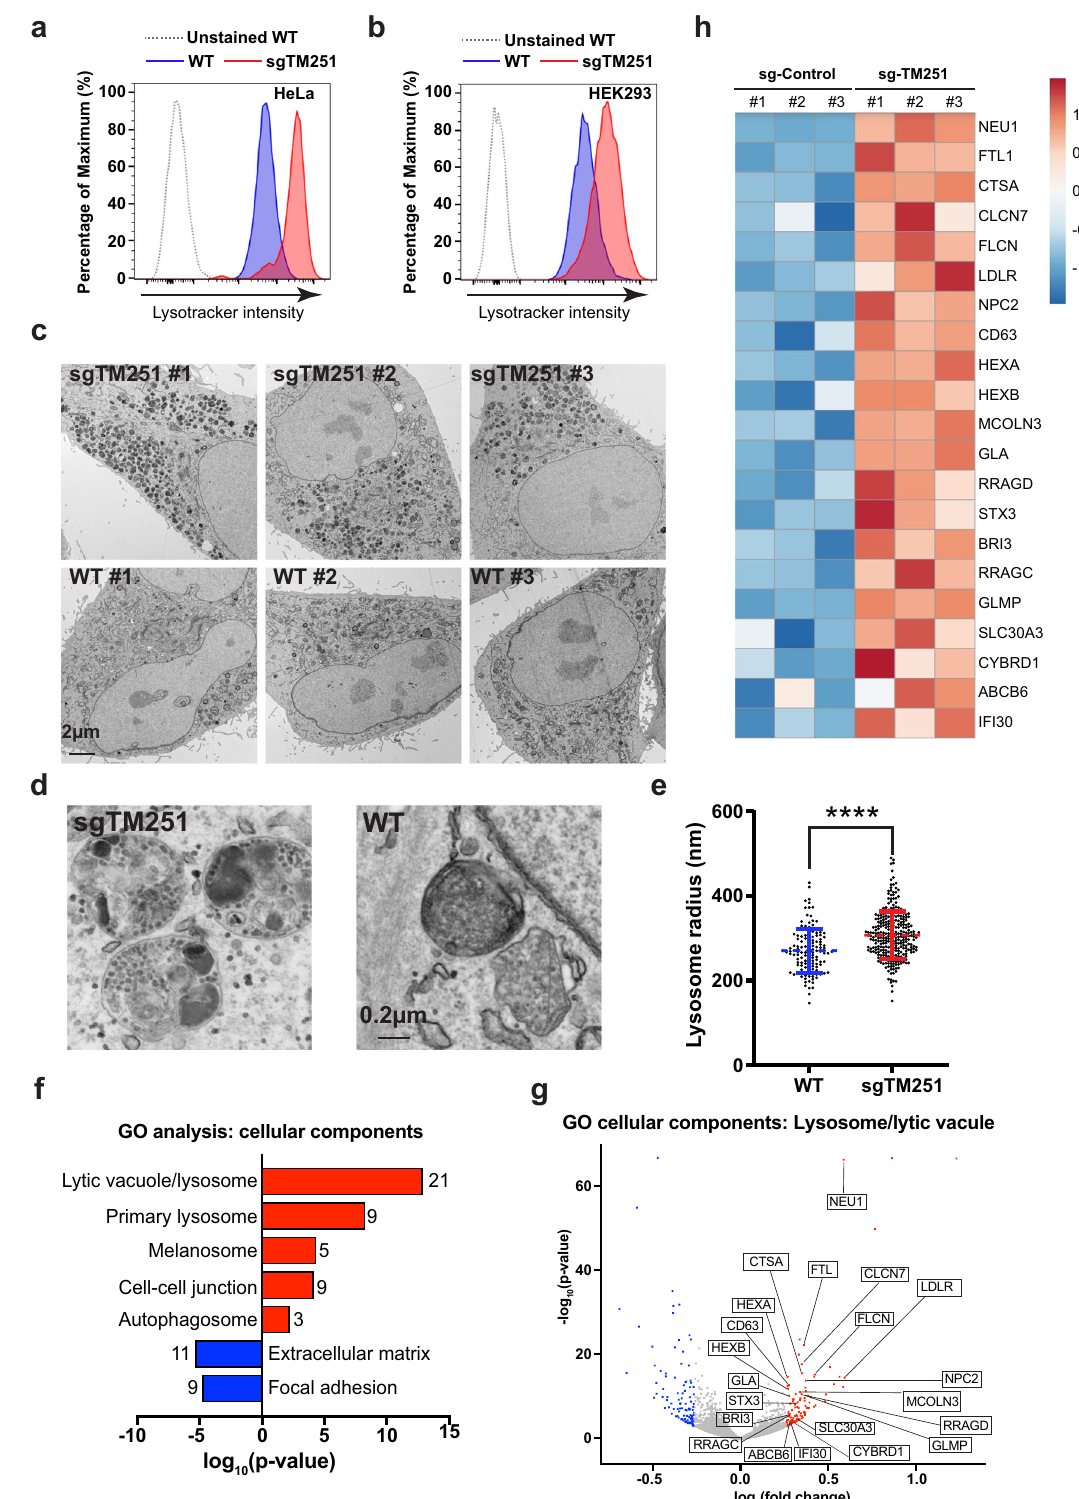
Fig. 3 | Ablation ofTMEM251upregulates lysosomebiogenesis. a , b Lysotracker intensity of WT vs. sgTMEM251 in HeLa ( a ) and HEK293 ( b ) cells. c Representative TEM images of HeLa WT ( n =100) and sgTMEM251 ( n =100) cells. Scale bar: 2 µ m. d Representative zoomed-in TEM images of lysosomes in HeLa WT ( n =100) and sgTMEM251( n =100)cells.Scalebar:0.2 µ m. e Quanti fi cationoflysosomeradiusin HeLa WT ( n =131) and sgTMEM251 ( n =297) cells. Mean of the quanti fi cation is shown with error bars representing the standard deviation. **** p ≤ 0.0001. See